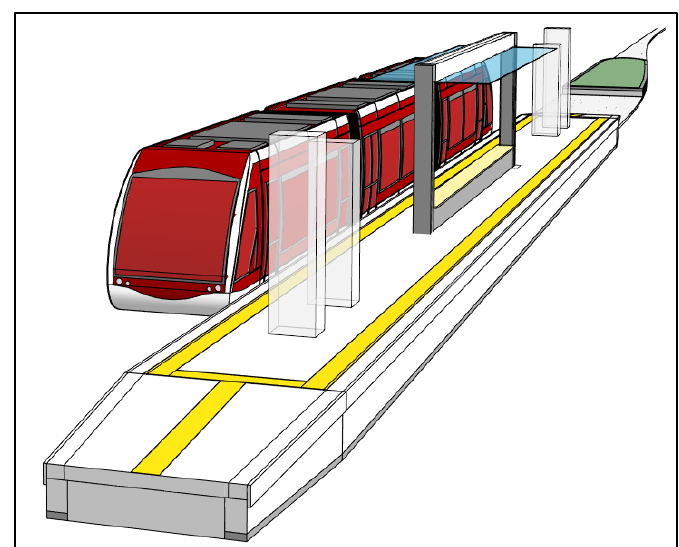
Figure 10. Tramway stop 3D model on